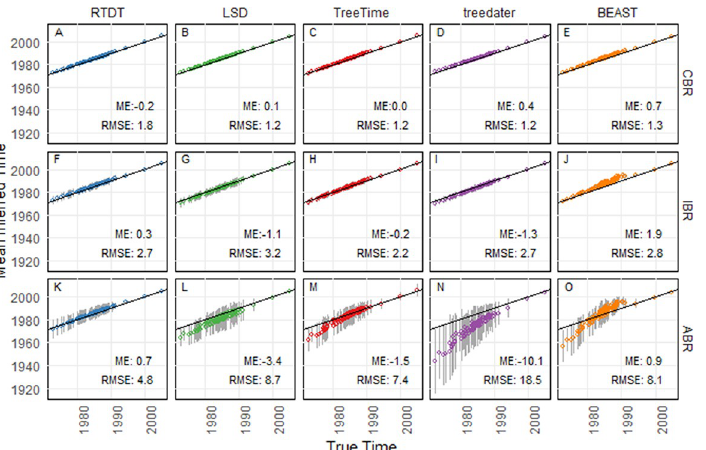
Fig 3. Estimates (average node time) for computer-simulated datasets of HIV-1 subtype F. The model tree is presented in Fig 2 . RTDT (blue), LSD (green), TreeTime (red), treedater (purple), and BEAST (orange) were used for datasets simulated under the CBR clock model (A-E), IBR clock model (F-J), and ABR clock model (K-O). These averages were means from 50 simulated datasets (replicates) at each node, and error bars indicate standard deviation. For BEAST, we used a strict rate model for the analyses of datasets with CBR, and log-normal rate models were used for IBR and ABR datasets. Mean error (ME) and root mean square error (RMSE) are shown within each panel. Negative values of ME indicate overestimation, and positive values indicate a tendency to generate underestimates.